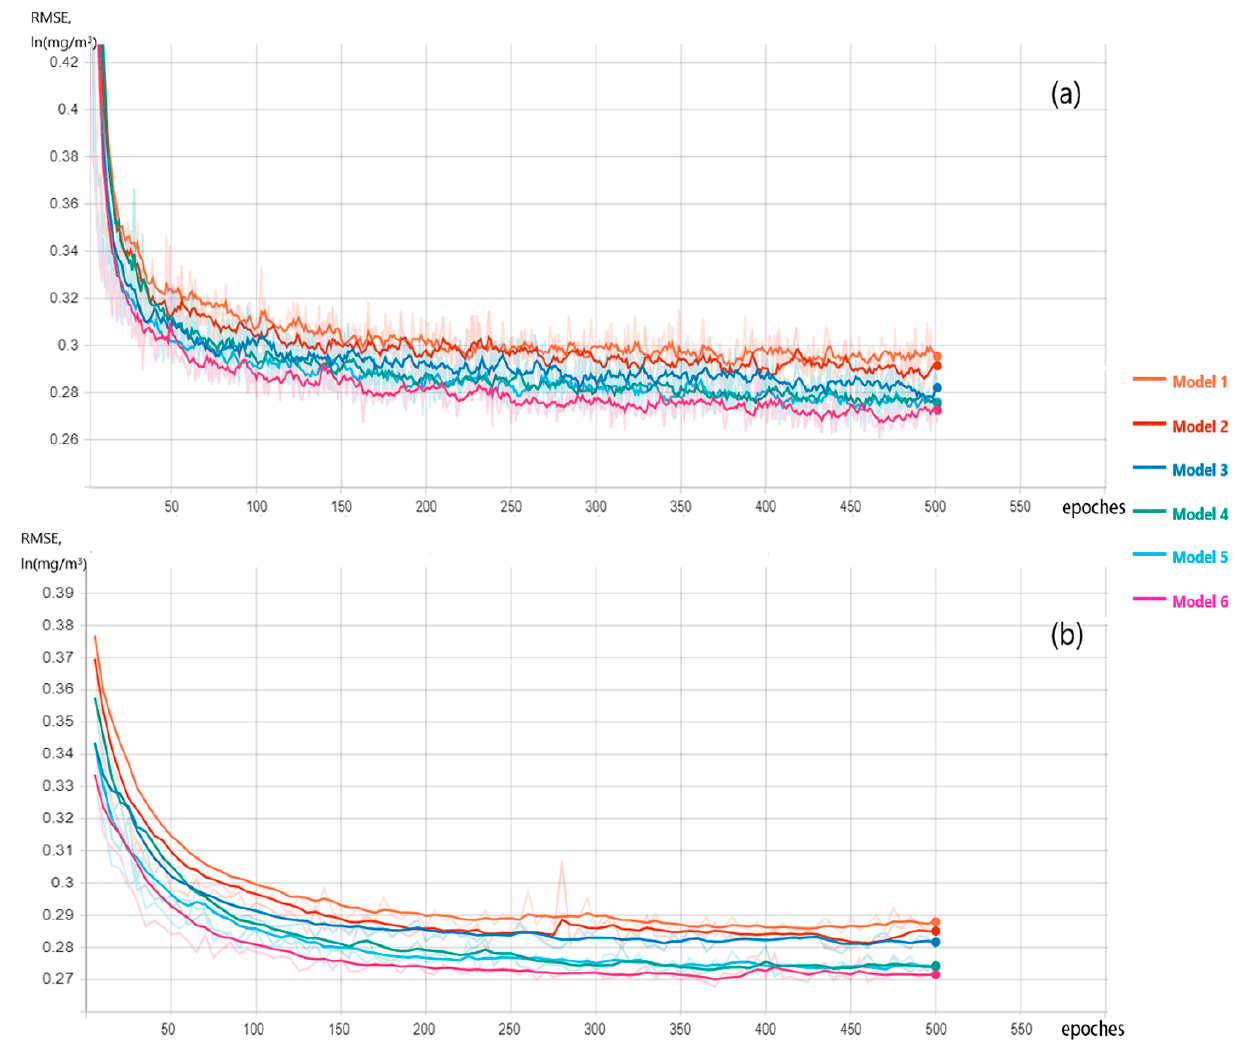
Figure 7. RMSEs are calculated throughout the training phase for the training set and the validation set. The curves are smoothed to show the trend. ( a ) RMSEs for 20 random batches in the training set are calculated with a step of 1 epoch with a batch number of 32. ( b ) RMSEs for the entire validation set are calculated at a step of 5